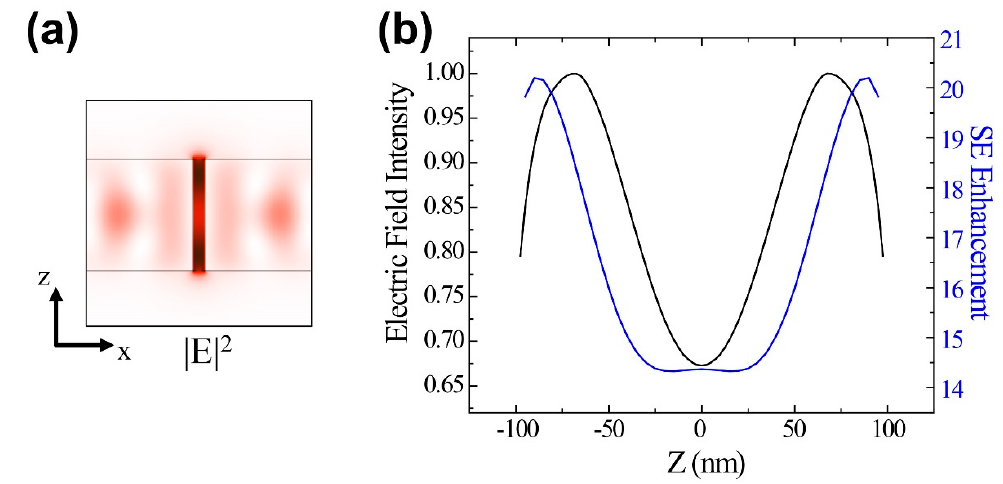
Figure 5. ( a ) Electric field intensity in the 660 nm resonance mode XZ plane ( y = 200 nm). ( b ) Electric field intensity and spontaneous emission (SE) enhancement from Figure 3c along the z -direction at the UC slot center ( y = 200 nm).